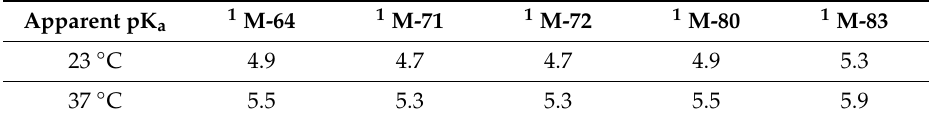
Table 5. pK a Values of N -isopropylacrylamide Copolymers of Ethyacrylic Acid.